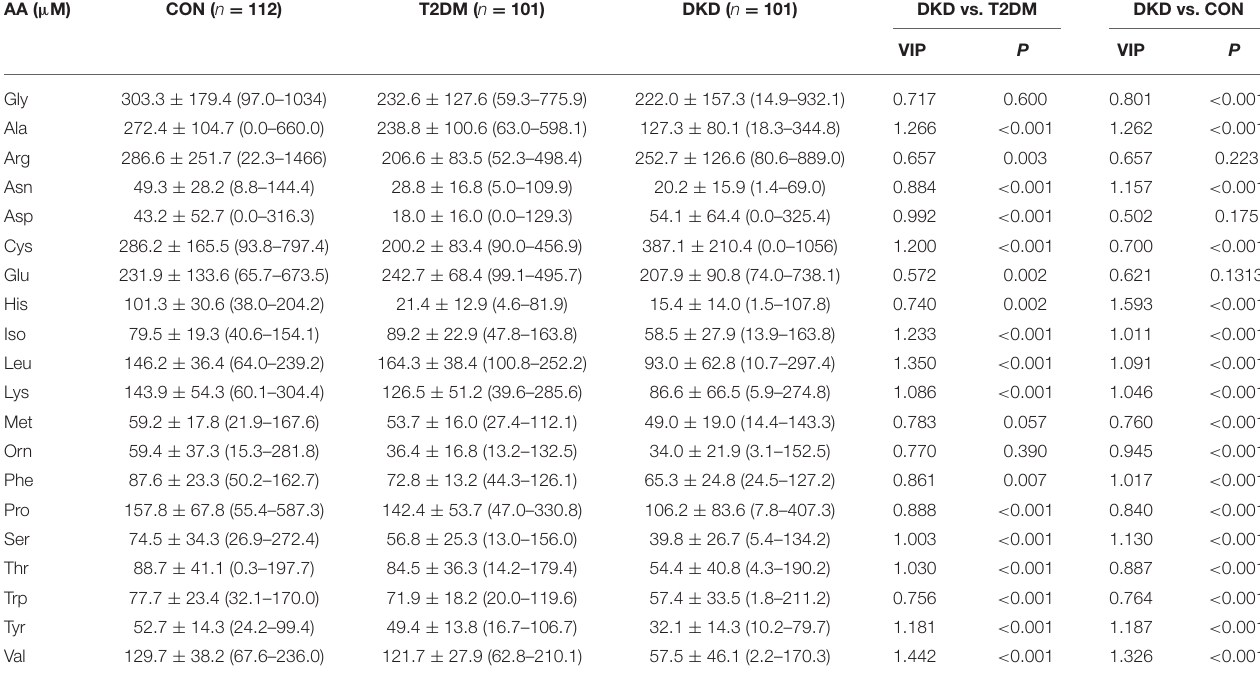
TABLE 1 | Plasma levels of the 20 amino acids in study participants.